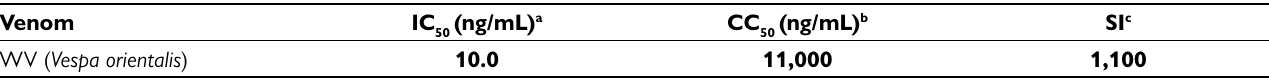
Table 1. Determination of IC